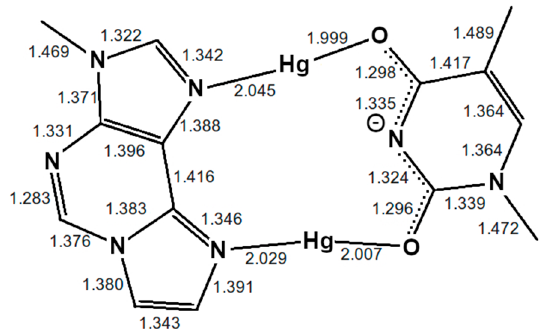
Figure 4. Optimized structure of the ε A –Hg(II) 2 – T base pair with interatomic distances in Å. The N3 atom of thymine is deprotonated. Both mercury(II) ions form coordinate bonds involving one nitrogen atom of ε A (N6 or N7) and one oxygen atom of T (O2 or O4), resulting in the NO -bonding pattern.